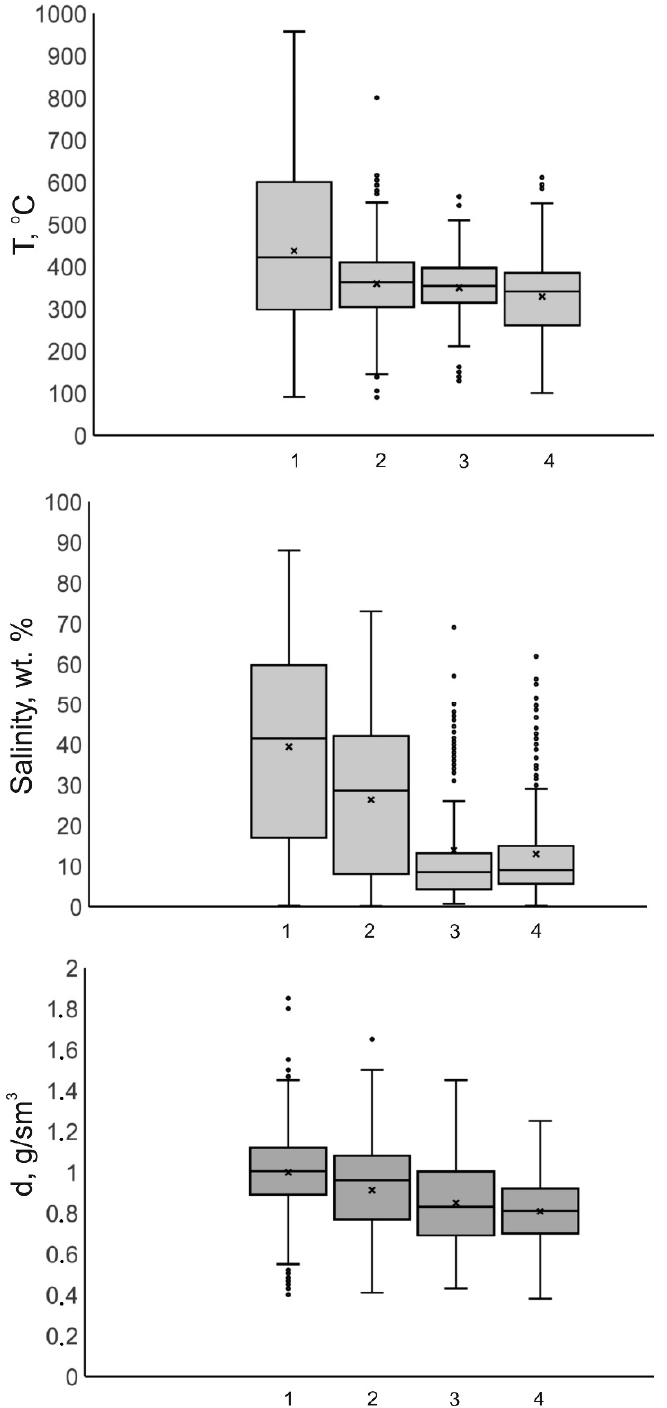
Figure 9. Boxplots for the homogenization temperatures of fluid inclusions, for the salinity of min- eralizing fluids and for the density of mineralizing fluids at porphyry deposits of various types (1– Cu (Au); 2–Cu, Mo (Au); 3–Mo;